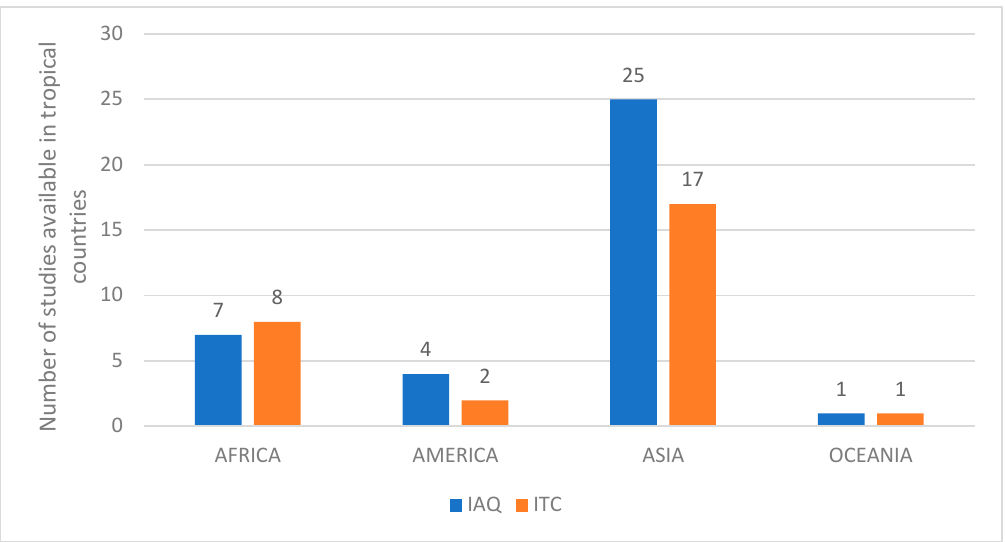
Figure 3. Number of studies available in the di ff erent tropical countries on di ff erent continents.